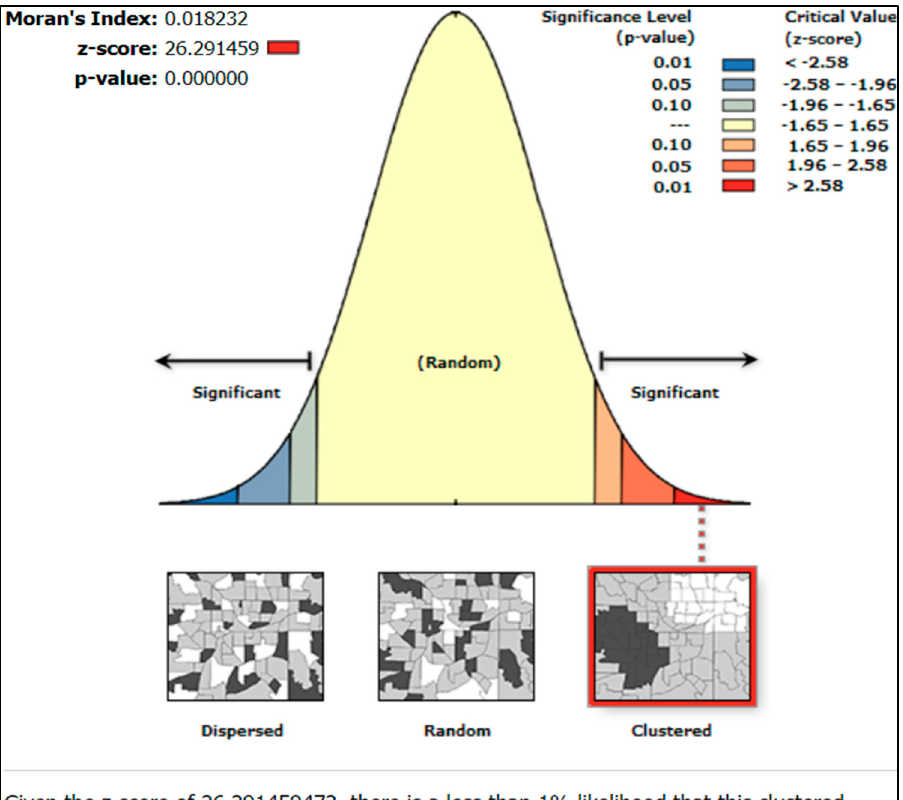
Figure 7. Spatial autocorrelation report with the significance graph of Moran’s I, z-score, and p -value of traffic accidents in the Irbid Governorate using the data from 2015–2019. Table 3. The global Moran’s I summary by distance as calculated by the incremental spatial auto- correlation function.